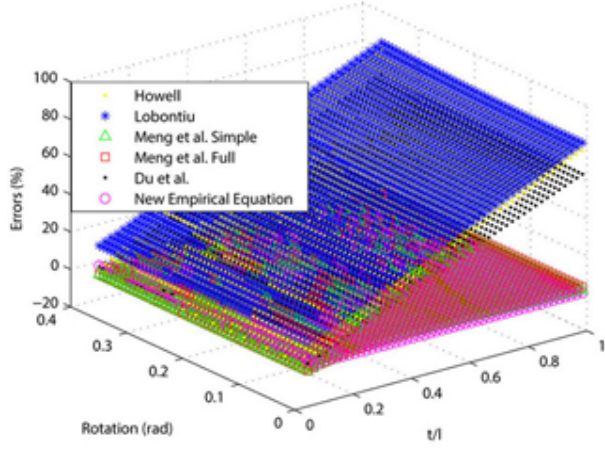
Figure 13. Errors of comparison results.